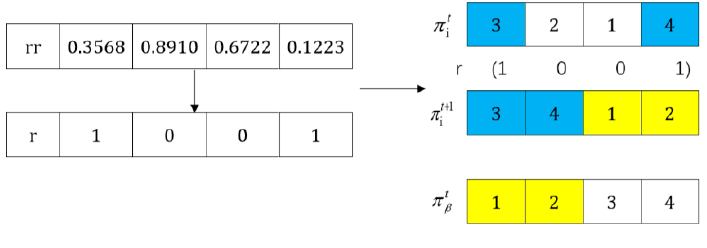
Figure 4. LMOX cross mode.